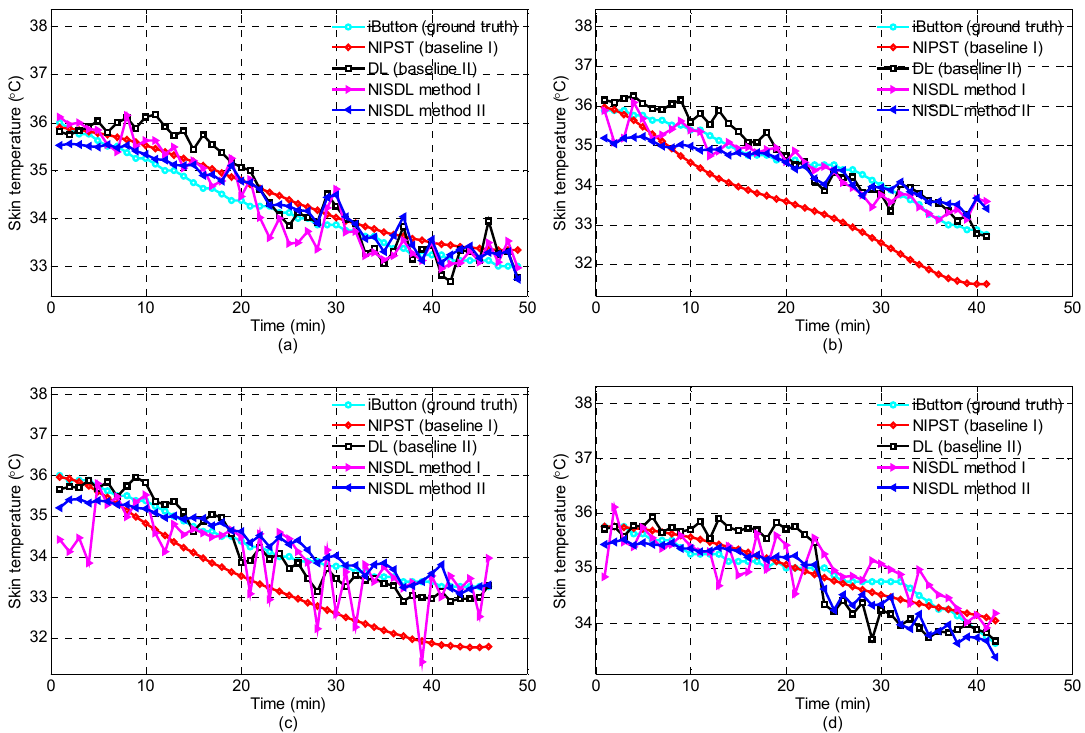
Figure 3. Skin temperatures comparison between ground truth, baseline and NISDL (Images of 12 subjects (0.96 million images) were training set; images of 4 subjects (0.32 million images) were test set. Sub-figures (a), (b), (c) and (d) are the comparison results of 4 test set (data of 4 subjects)).